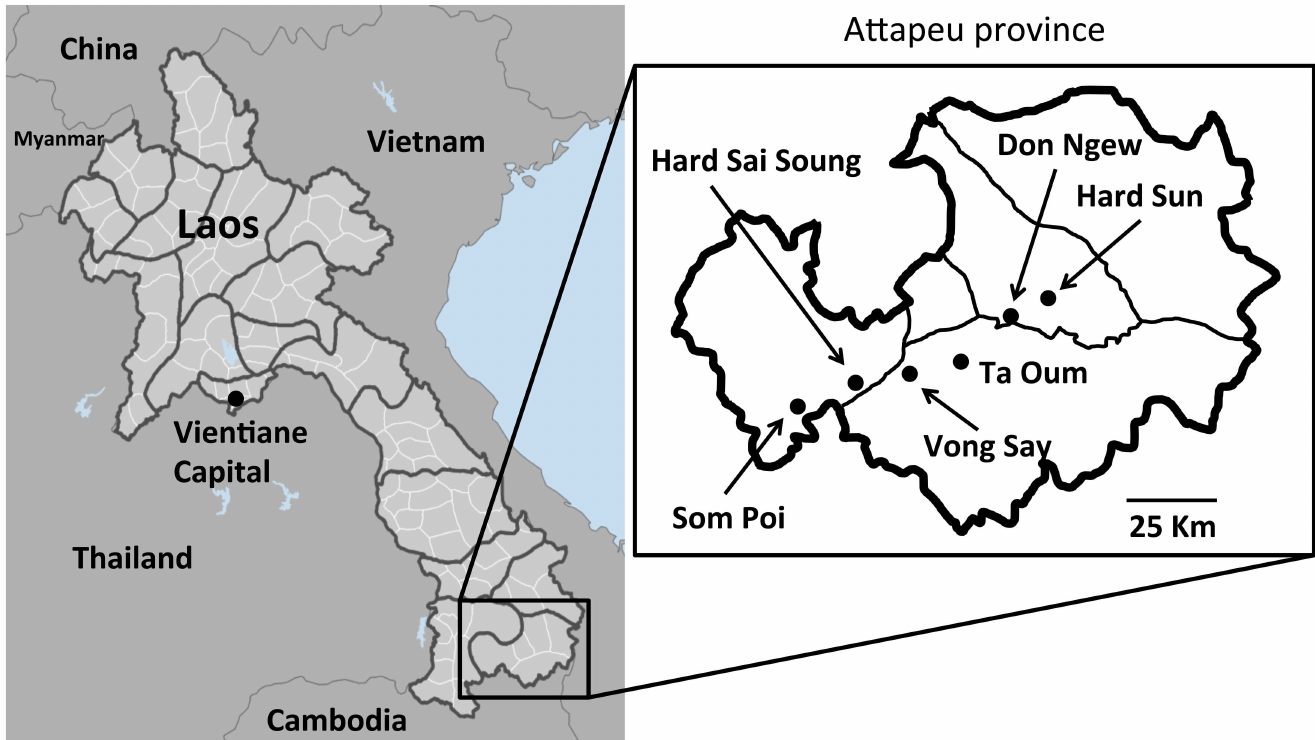
Fig 1. Study sites in Attapeu province, the Lao PDR. Don Ngew and Hard Sun villages are locatedin Xaysetha district (API = 31.2); Vong Say and Ta Oum villages are locatedin Phouvongdistrict (API = 103.4); and Hard Sai Soung and Som Poi villages are locatedin Sanamxaydistrict (API = 59.9). API, annualparasite incidence(accordingto the API data from 2013). Map of Laos (left), Data source: CIESIN, CIAT, GPW, Availablefrom: http://sedac.ciesin. columbia.edu/gpw.Map of Attapeu province (right) was created by the authors.